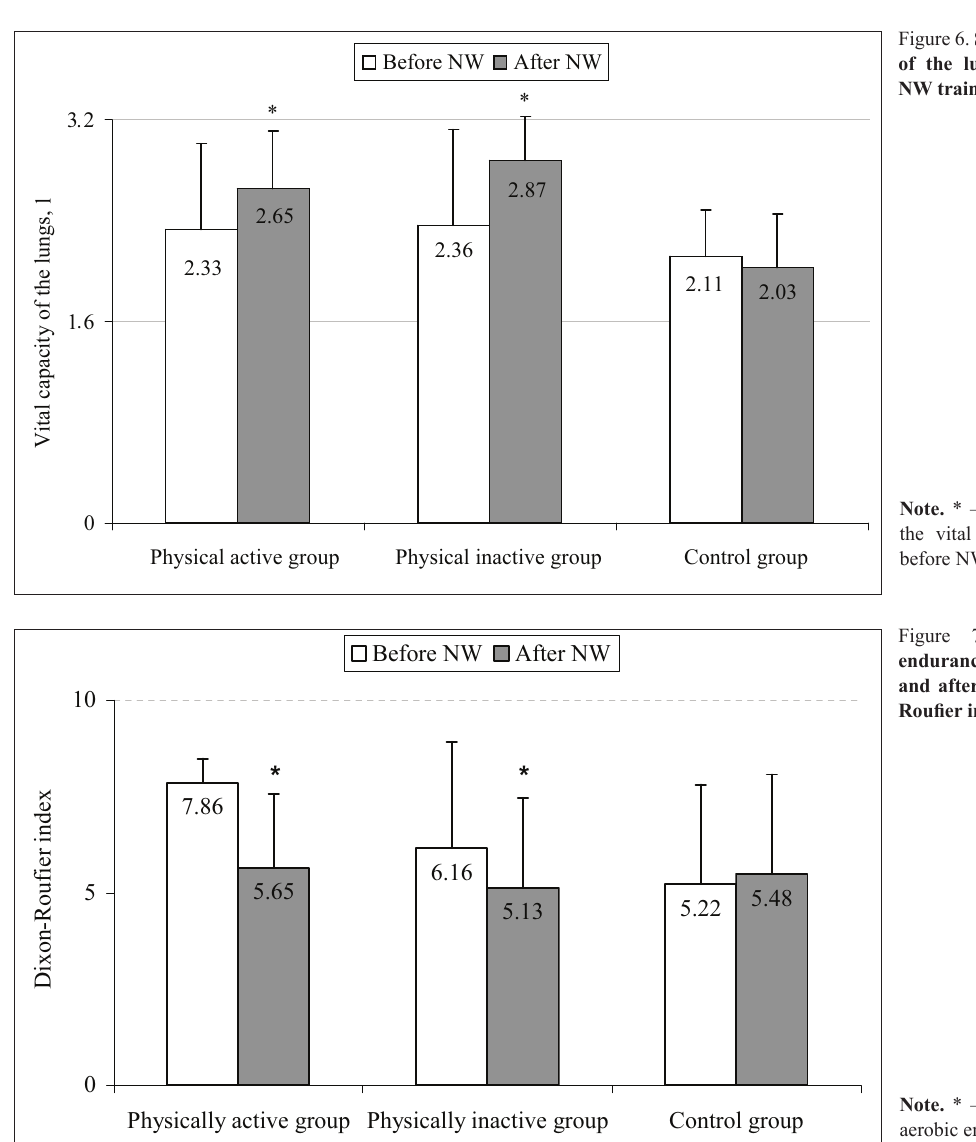
Note. * – p < 0,05 compared to aerobic endurance before